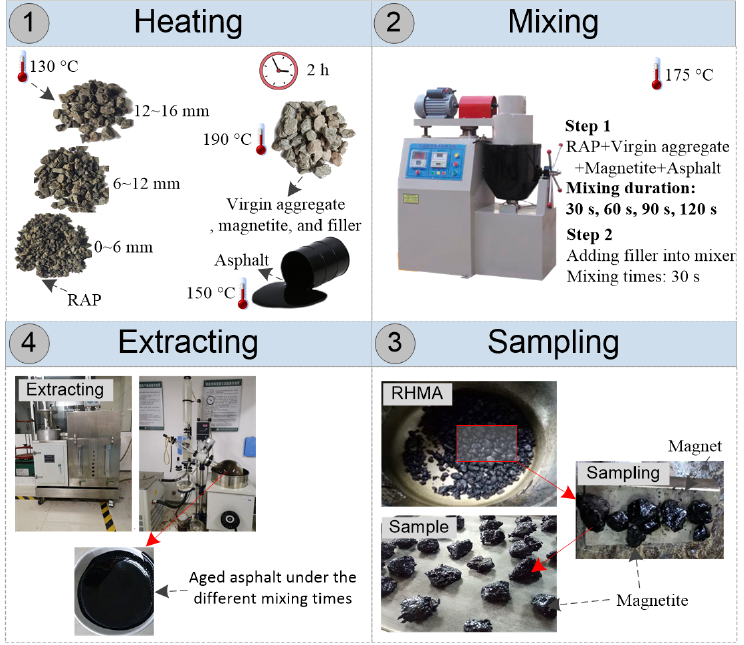
Figure 4. The process of blending asphalt with different mixing durations.